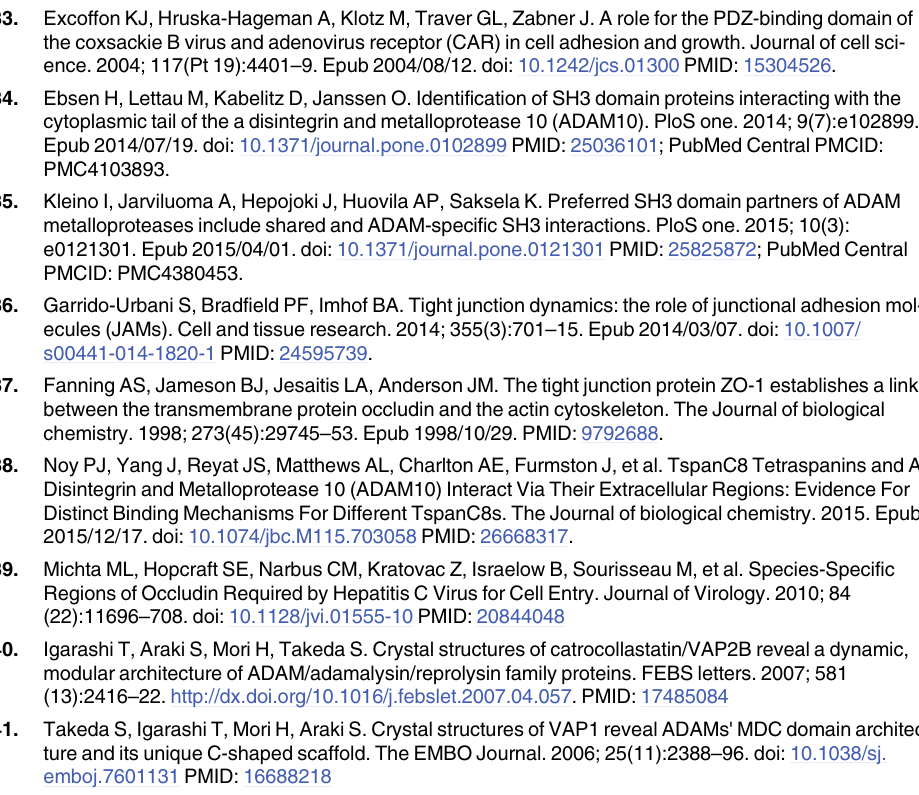
PLOS ONE | DOI:10.1371/journal.pone.0152921 April 4,